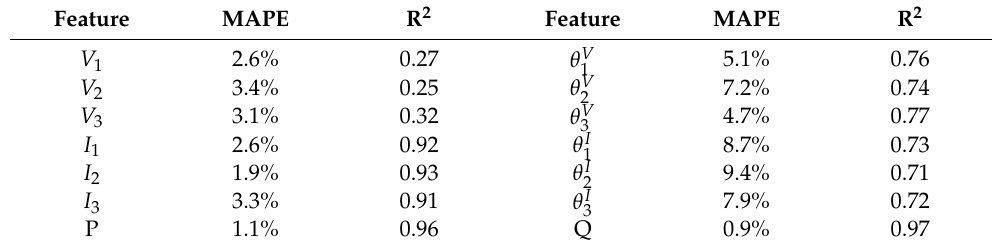
Table 1. Reconfiguration performance of each feature.